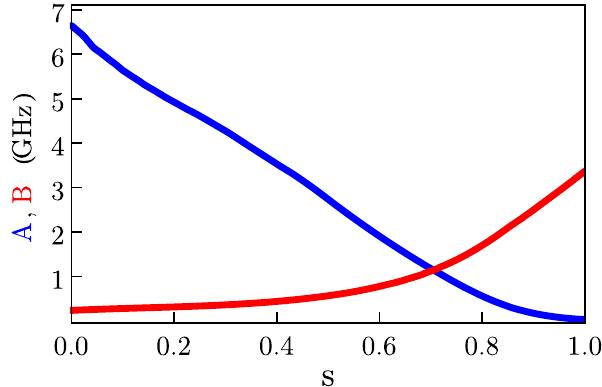
FIG. 10. Schedule functions for D-Wave 2X chip. The annealing parameter is s ¼ t=T time T QA